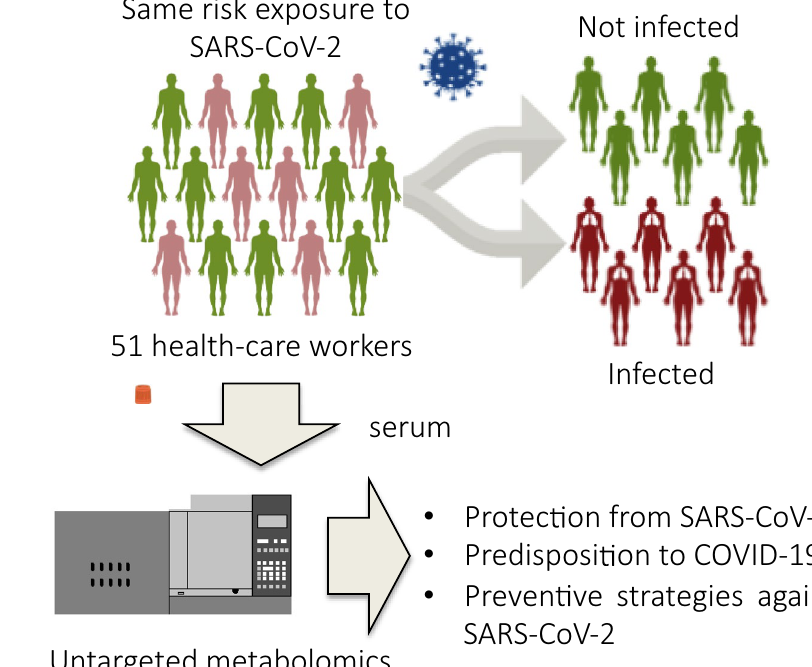
Figure 1. Experimental design of the study. Untargeted metabolomics was performed on 51 healthcare workers exposed to the same risk of contracting COVID-19. Twenty-four subjects developed COVID-19 in the weeks following the blood collection, while 27 subjects were more protected and did not develop the disease. The abundance of serum small molecules was used to identify the molecules that may protect individuals from SARS-CoV-2 infection or predispose them to developing